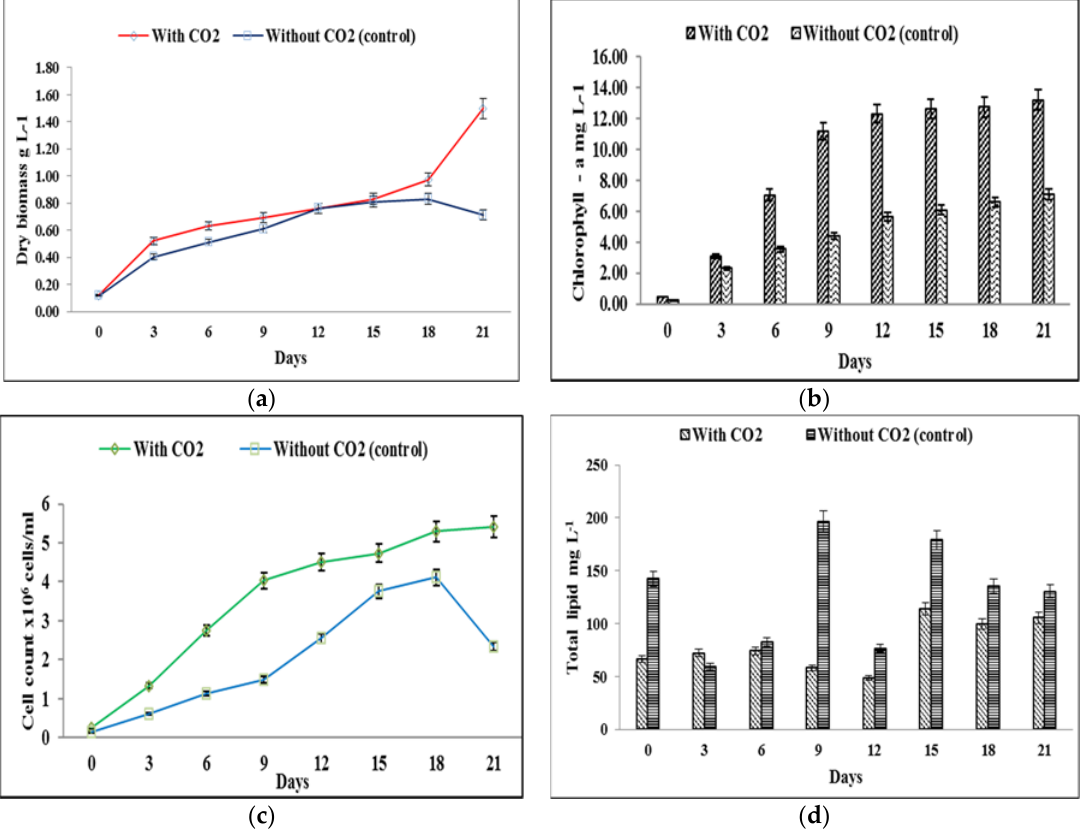
Figure 2. ( a ) Dry biomass of Amphora coffeaeformis RR03 with CO 2 and without CO 2- modified CFTRI-RRAC I medium at different intervals in 10.0 m 2 open raceway pond. ( b ) Cell count of A. coffeaeformis RR03 with CO 2 and without CO 2 -modified CFTRI-RRAC I medium at different intervals in 10.0 m 2 open raceway pond. ( c ) Chlorophyll- a content of A. coffeaeformis RR03 with CO 2 and without CO 2- modified CFTRI RRAC I medium at different intervals in 10.0 m 2 open raceway pond. ( d ) Total lipid content of A. coffeaeformis RR03 with CO 2 and without CO 2 -modified CFTRI-RRAC I medium at different intervals 10.0 m 2 open raceway